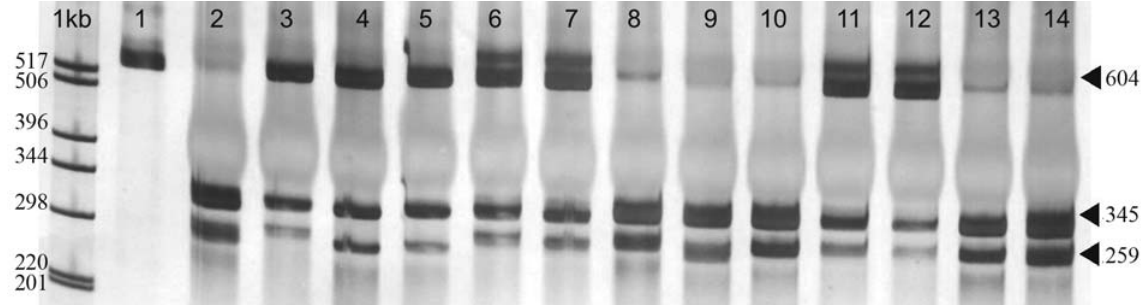
Figure 1 - Example of G316A polymorphism obtained by PCR-RFLP analysis in 8% polyacrylamide gels using silver staining of material from F2 pigs. Eachlane(1-14)representsaseparate pig.1kb=DNALadder(InvitrogenInc.). Lane1=genotypeAA;Lanes2,8,9,10,13and14=genotypeGG;Lanes 3-7, 11 and 12 = genotype GA. Arrows represent the size of the PCR-RFLP fragments